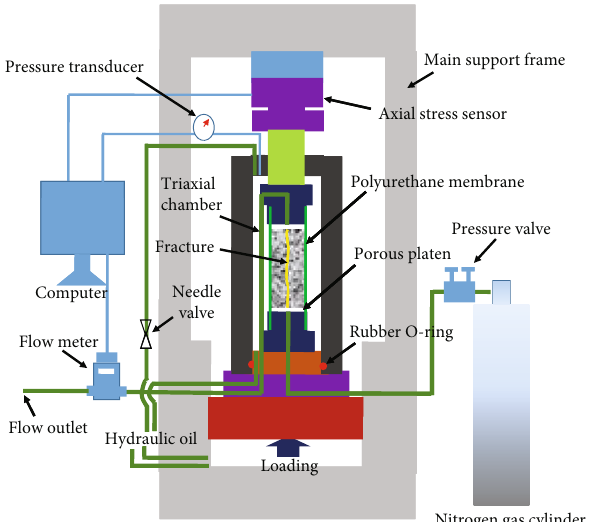
Figure 3: Schematic diagram of the experimental setup.